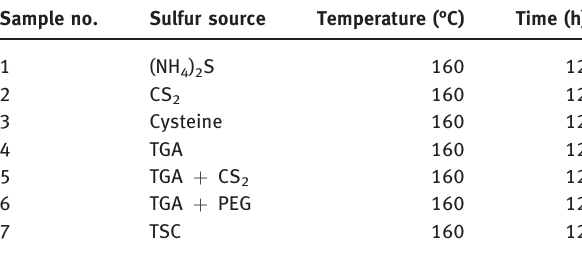
Table 1: Experimental conditions for preparation of PbS